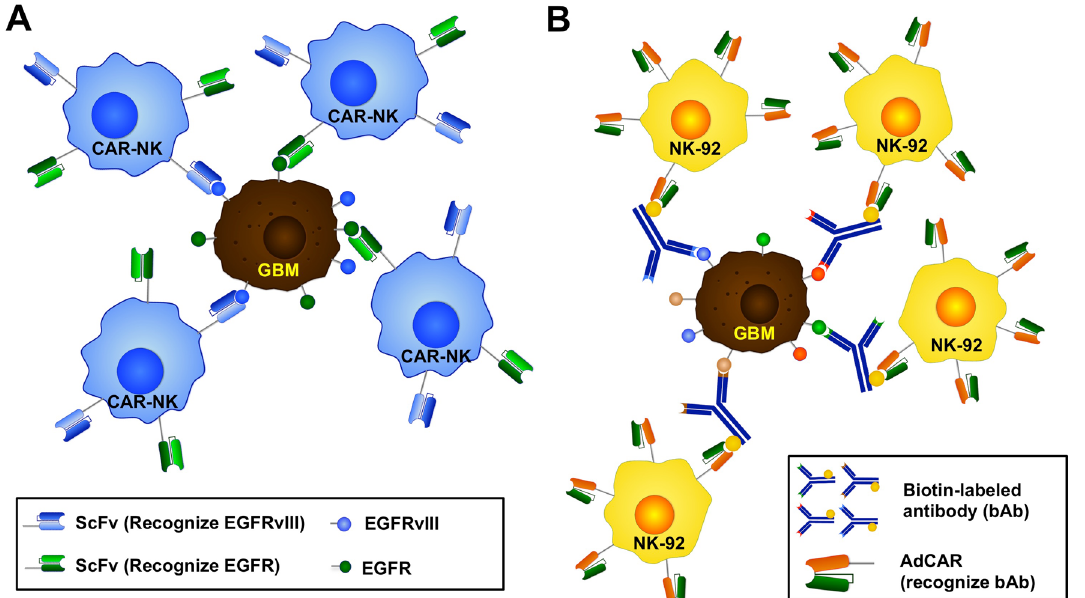
Fig. 2 Dual antigen-targeting and adapter chimeric antigen receptor (AdCAR) therapy in glioblastoma (GBM). A Structure and recogni- tion of dual antigen-targeting CARs in NK cells. NK cells express scFvs that recognize Epidermal growth factor receptor (EGFR)vIII or EGFR. Therefore, these NK cells can recognize not only GBM cells expressing both EGFRvIII and EGFR but also cells expressing only one of them. B AdCAR therapy in GBM. AdCAR can recognize bAb. AdCAR is designed to recognize bAb and is used in conjunction with bAb, which can recognize cancer surface antigens. The important thing is that once AdCAR NK cells are made, it is possible to control them by simply changing bAb, even if the surface antigen of the patient’s cancer changes. Therefore, the use of AdCAR brings flexible and economical ben- efits for patient-specific immunotherapy. Please see the main text for